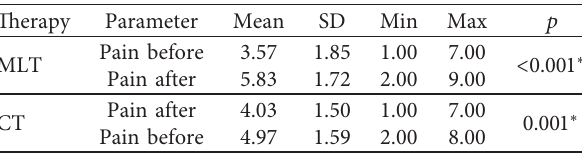
Table 1: Comparison of pain parameters on the VAS scale during the daily activity of the mandible before and after the therapy in each group ( n � 30).